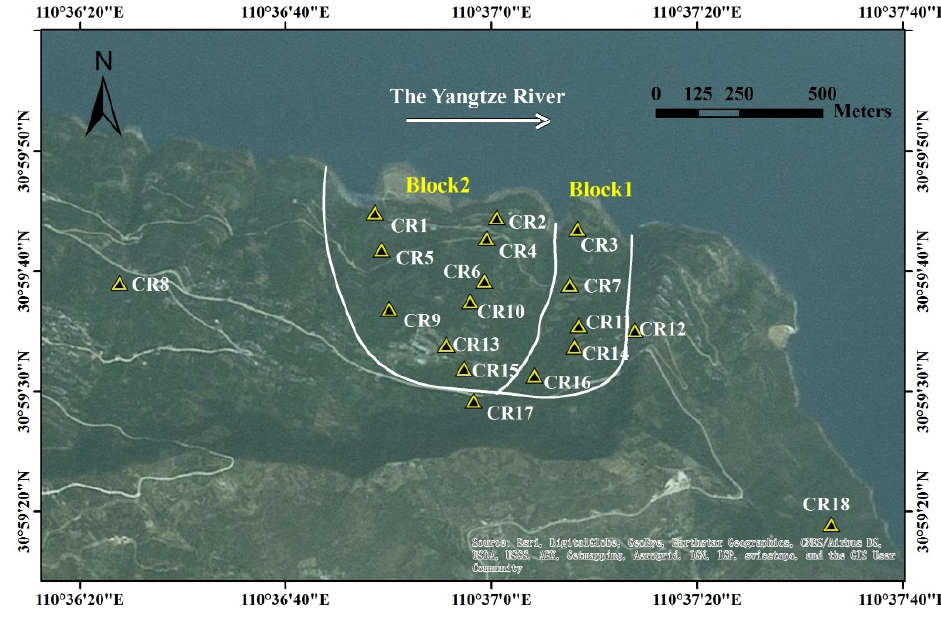
Figure 5. The distribution of 18 corner reflectors at Shuping landslide.